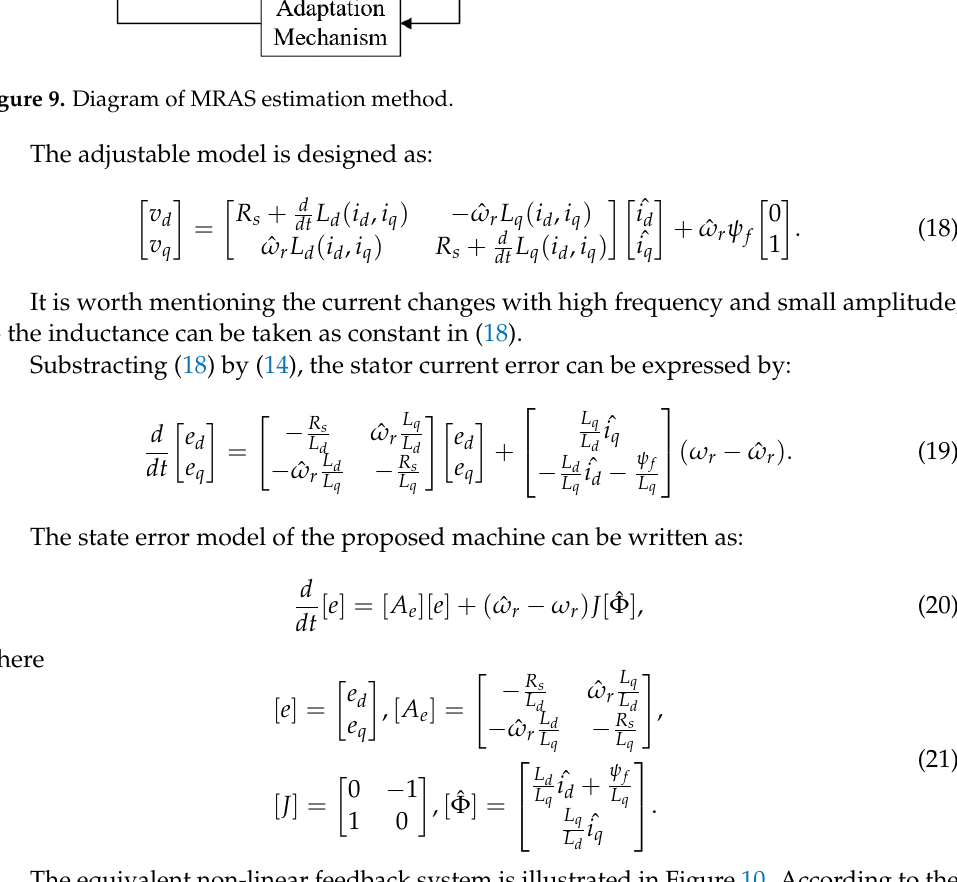
Figure 9. Diagram of MRAS estimation